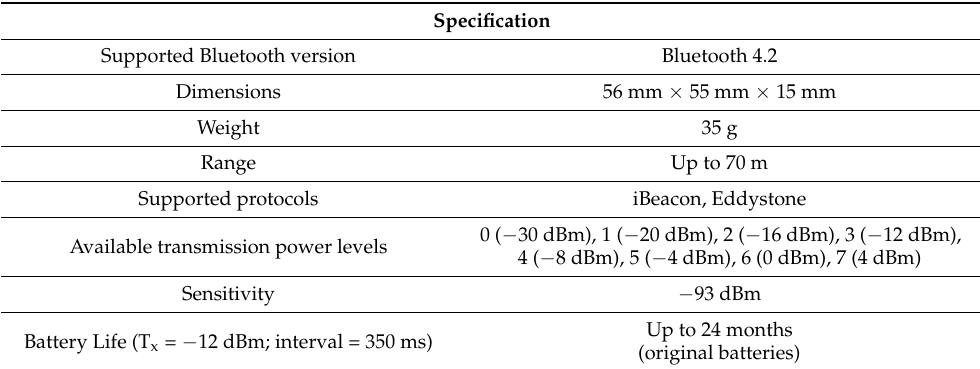
Figure 1. Original kontakt.io Smart Beacon SB16-2. Table 1. Smart Beacon SB16-2 specification